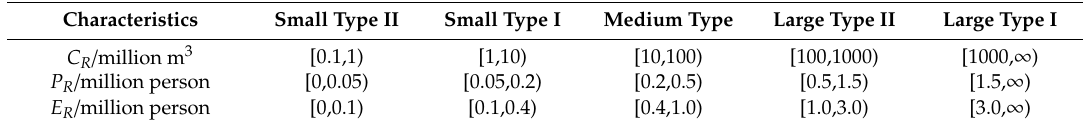
Table 2. Main characteristics of reservoirs at all types in